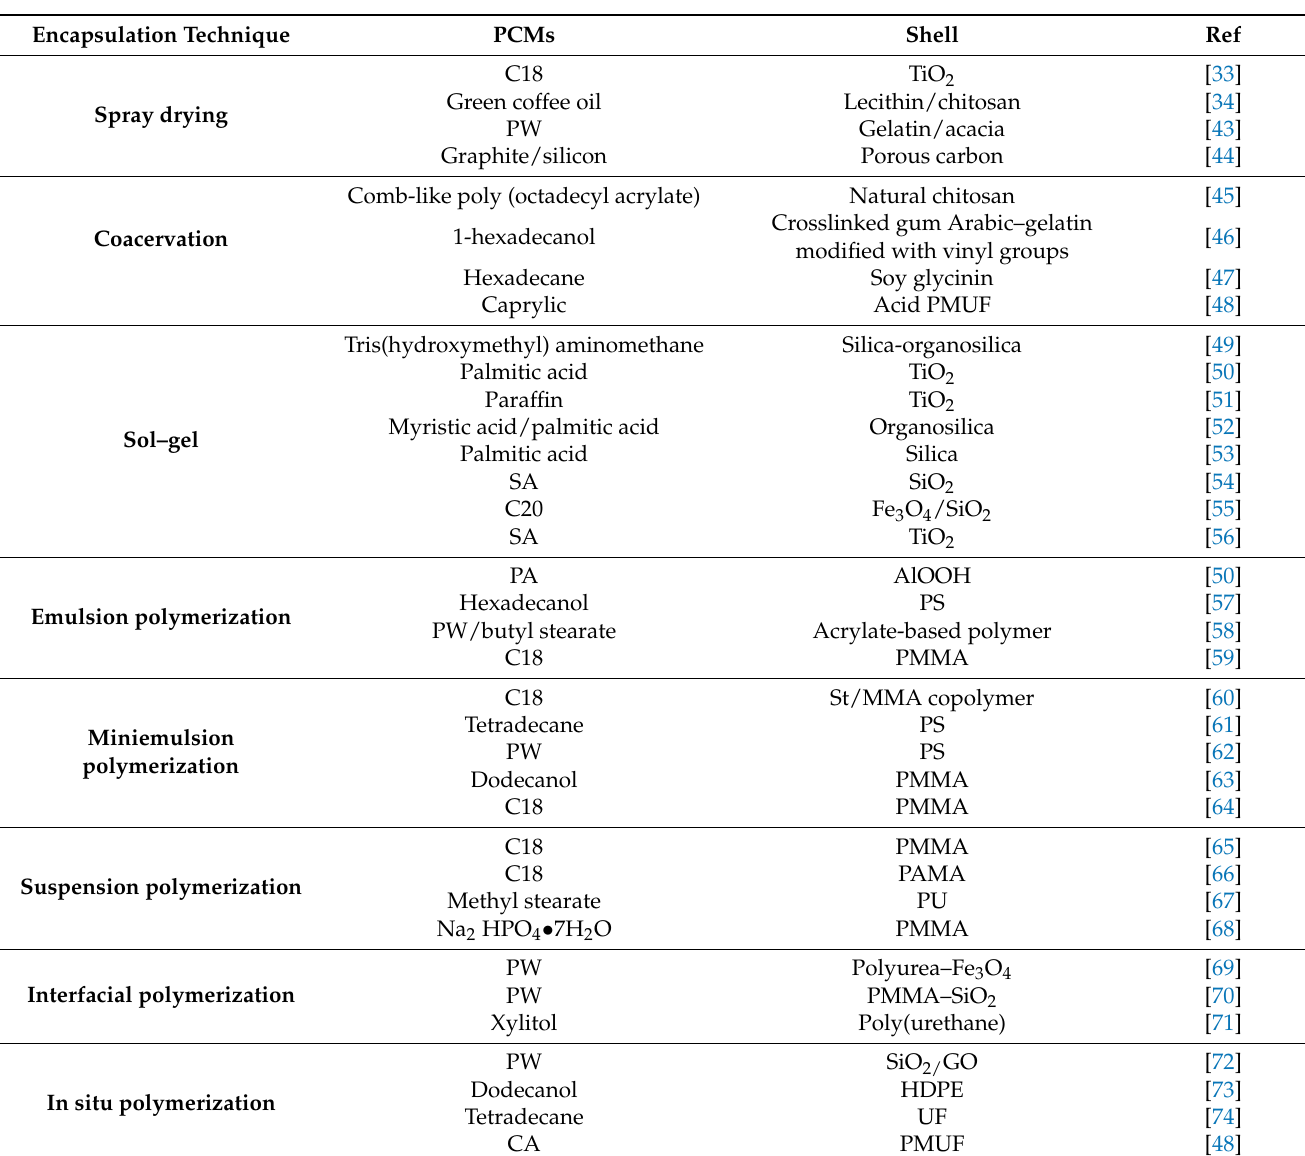
Table 2. Summary for encapsulated